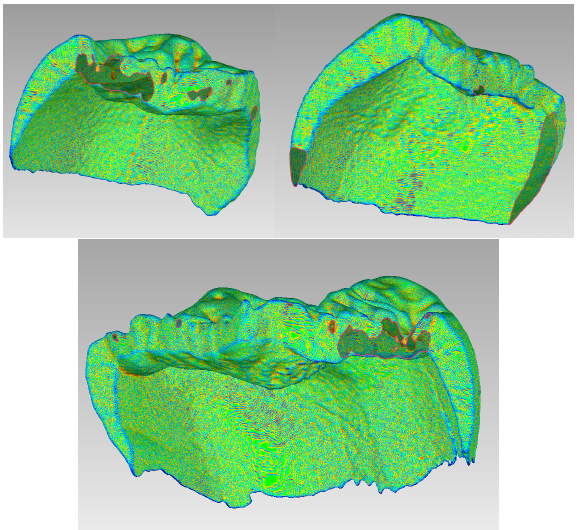
Figure 6. Flat images of sample 269 as sections in three perpendicular planes